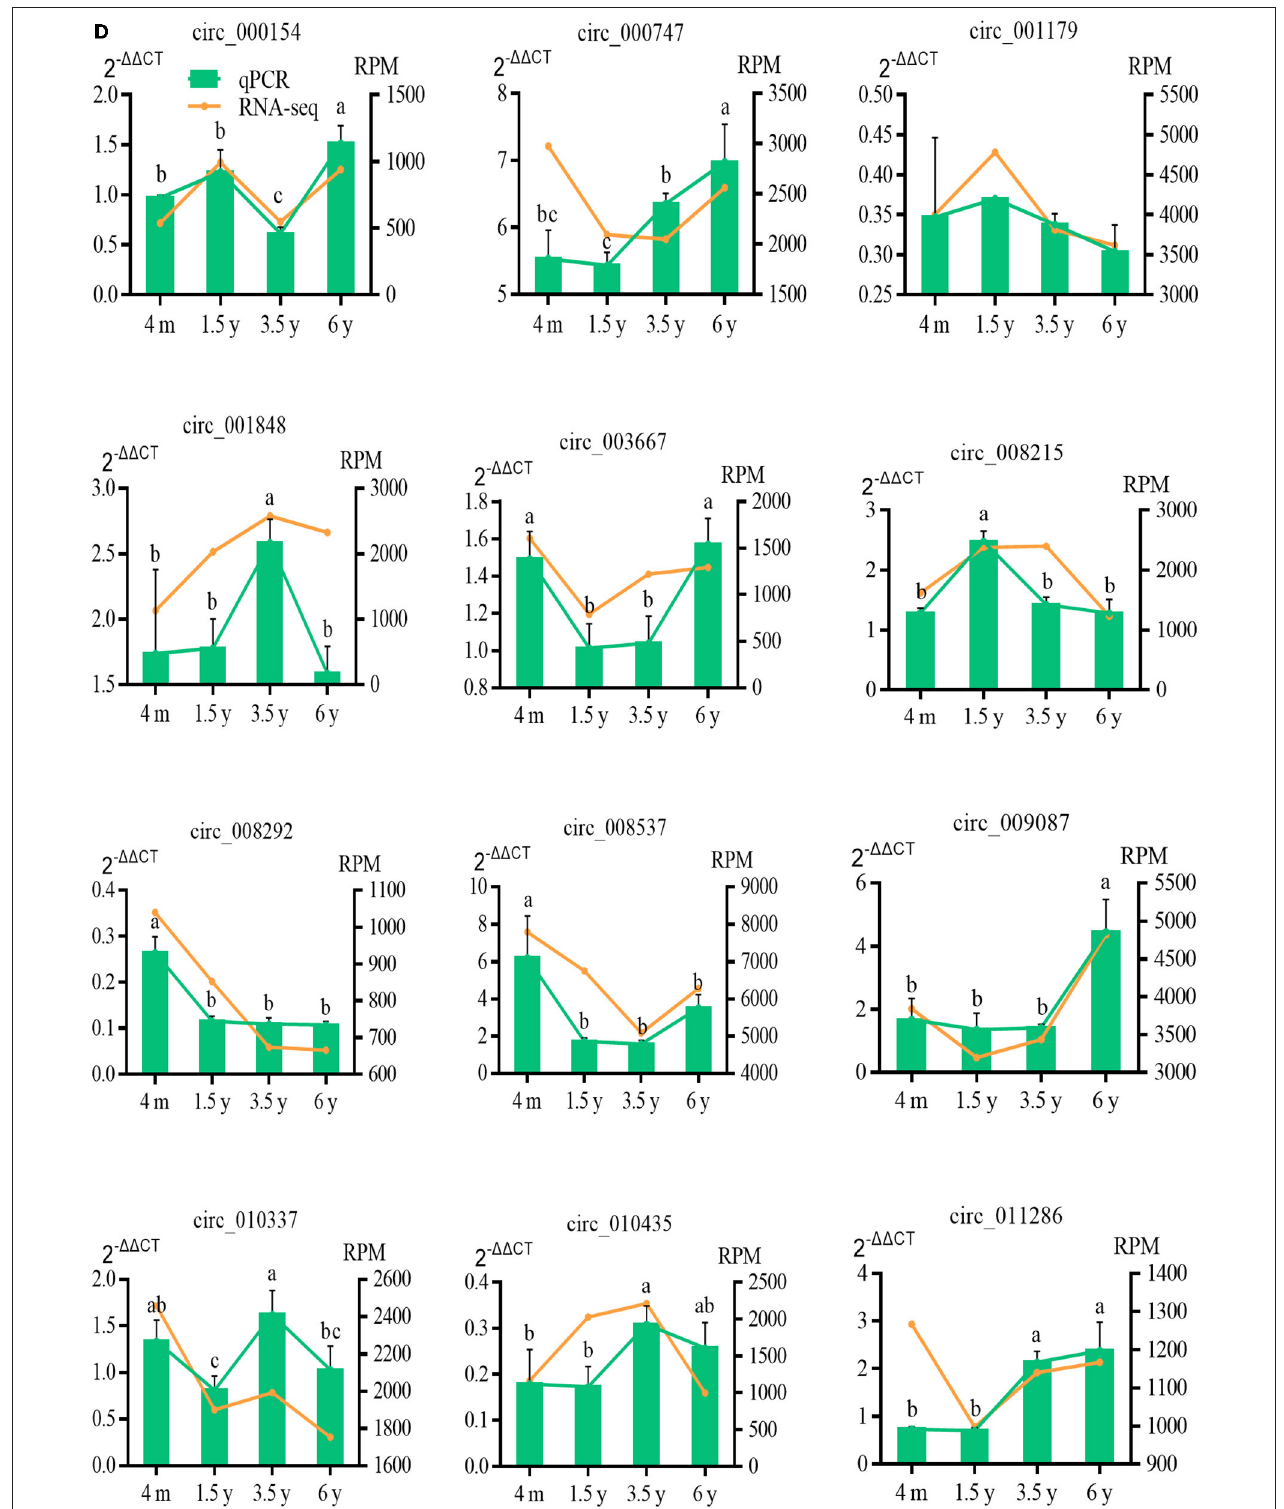
FIGURE 6 | Verification of 12 randomly selected circRNAs from RNA-Seq. (A) Divergent primers were designed used to circRNA verification. (B) PCR amplification of circRNAs with divergent primers. PCR products were visualization analyzed on a 1.5% gel electrophoresis. (C) Circular junctions were confirmed by Sanger sequencing of RT-PCR products using divergent primers. (D) Comparison of the expression levels of circRNA between RNA-Seq and RT-qPCR. RT-qPCR data were shown as the means ± SD. Different letters (a–c) indicated significant difference between different ages ( p < 0.05).